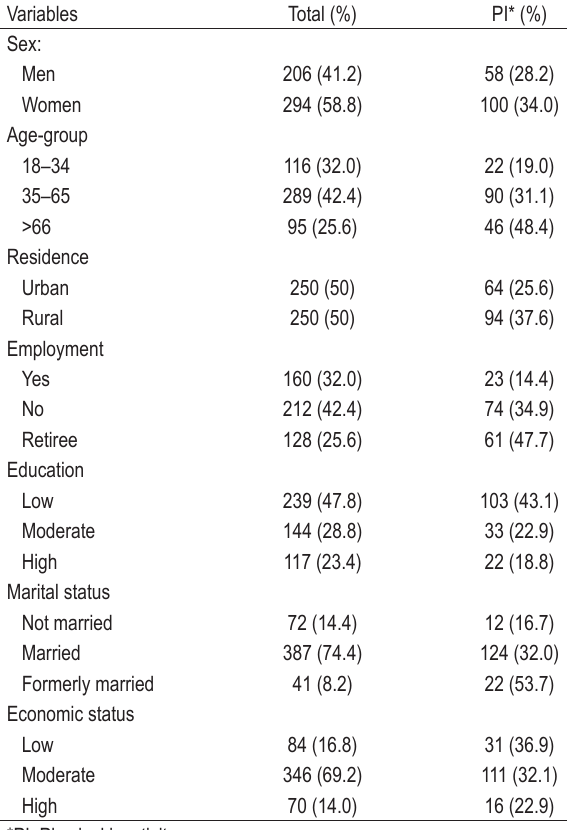
TABLE 1. Distribution of socio‑demographic characteristics and PI prevalence among adult primary health care users. Absolute numbers and their respective row percentages